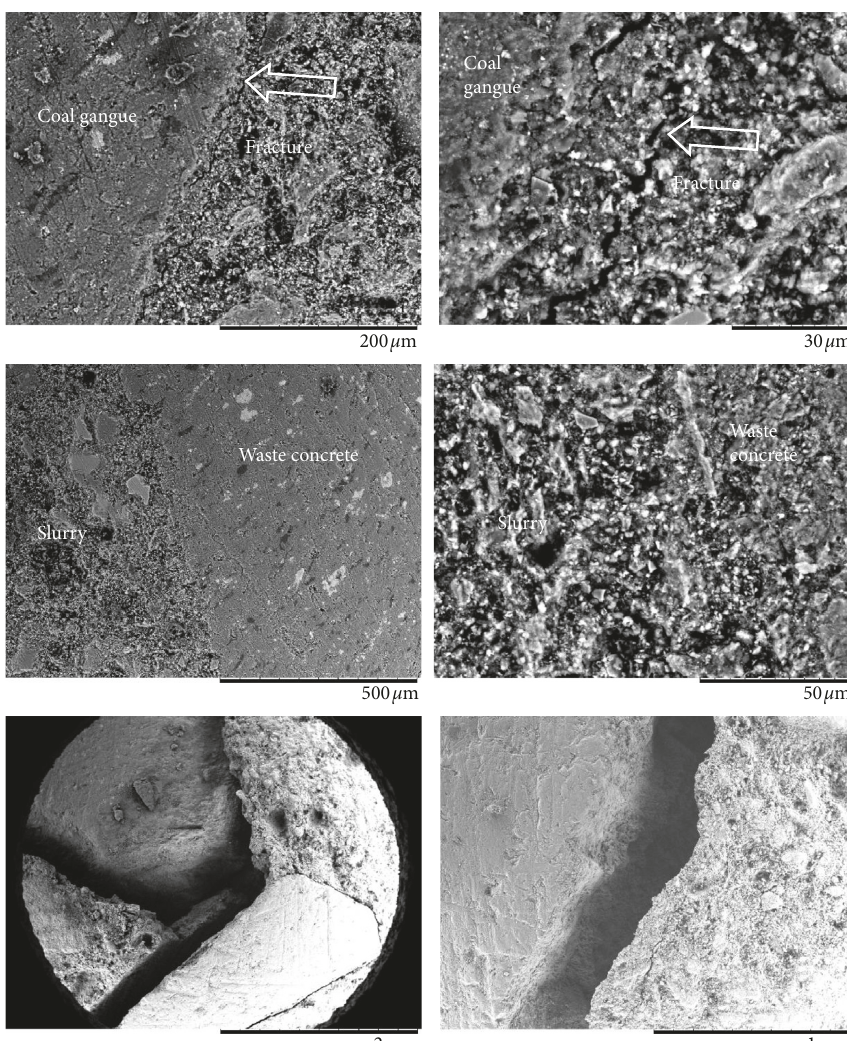
Figure 5: SEM photos of the CGB sample under axial compression.